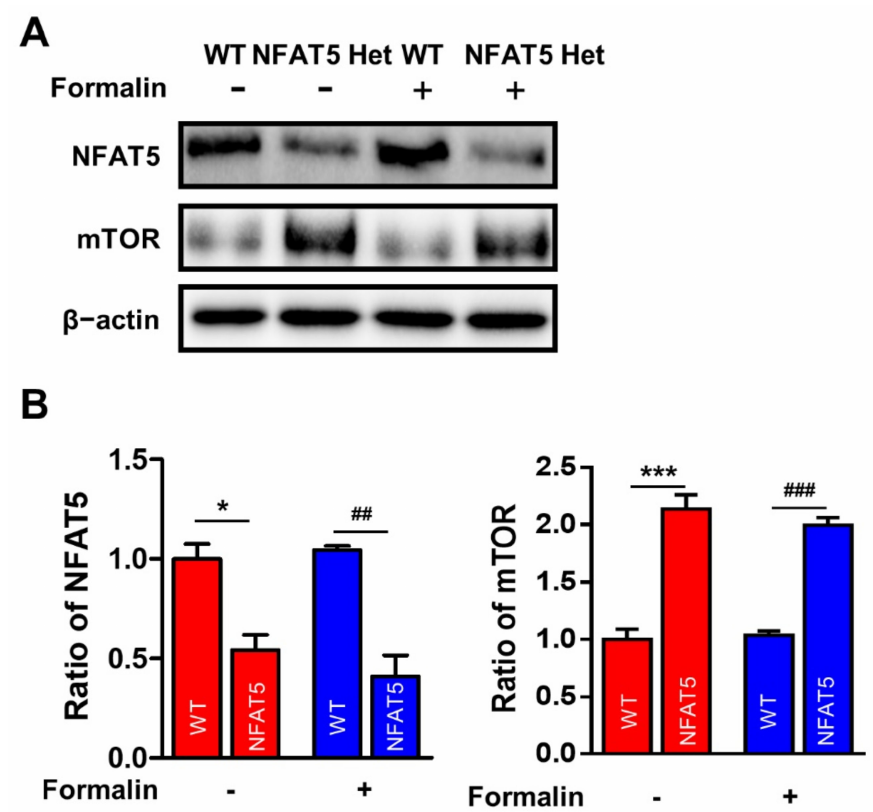
Figure 6. Upregulation of mTOR expression in the spinal cord of NFAT5-Het mice. ( A ) The levels of mTOR expression were examined before and after formalin injection in the ipsilateral sides of the spinal dorsal horns in WT and NFAT5-Het mice using Western blot analysis. ( B ) Band intensities represented as the ratios of mTOR normalized to β -actin. Data are expressed as the means ± SEMs (one-way ANOVA with Tukey’s post-hoc test, * p < 0.05 vs. WT formalin (-), *** p < 0.001 vs. WT formalin (-), ## p < 0.05 vs. WT formalin (+), ### p < 0.001 vs. WT formalin (+), n =